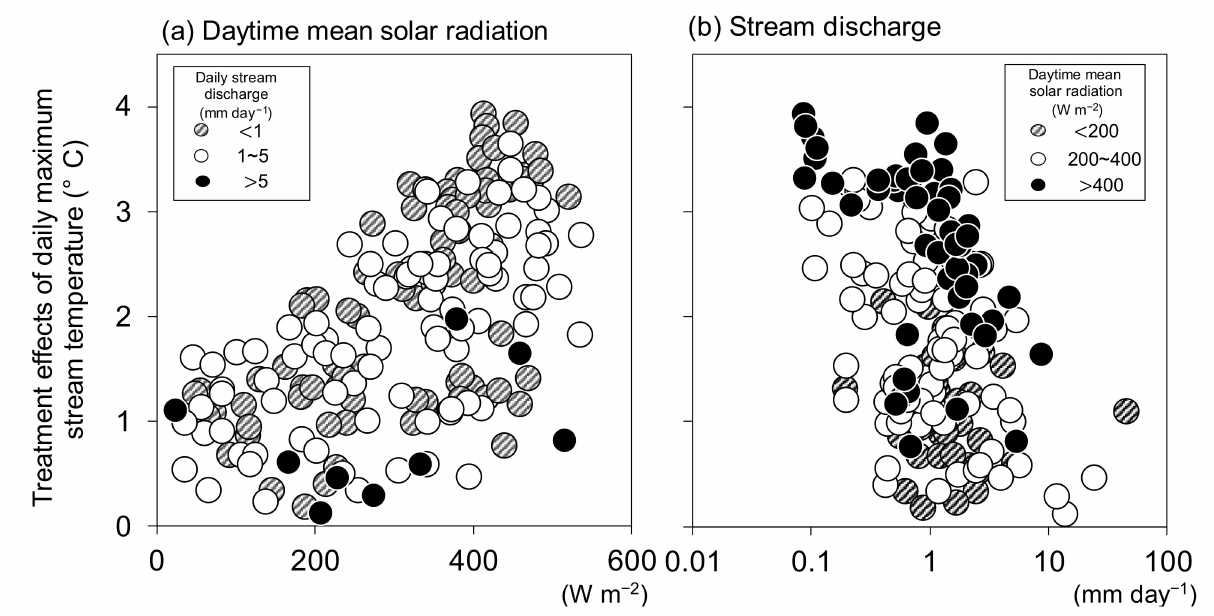
Figure 6. ( a ) Relationship between daytime mean solar radiation and treatment effects of daily maximum stream temperature by the classification of discharge classes. ( b ) Relationship between stream discharge and treatment effects of daily maximum stream temperature by the classification of solar radiation classes. Data from April to September 2012 were used for these plots.